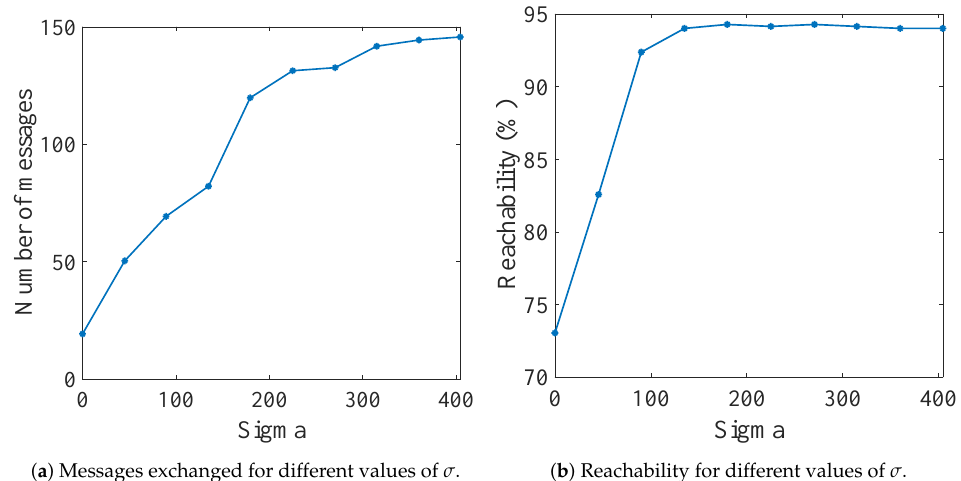
Figure 5. Number of messages exchanged and reachability in hovering area A for different values of σ when the vehicle density is set to 6.7 vehicles/Km 2